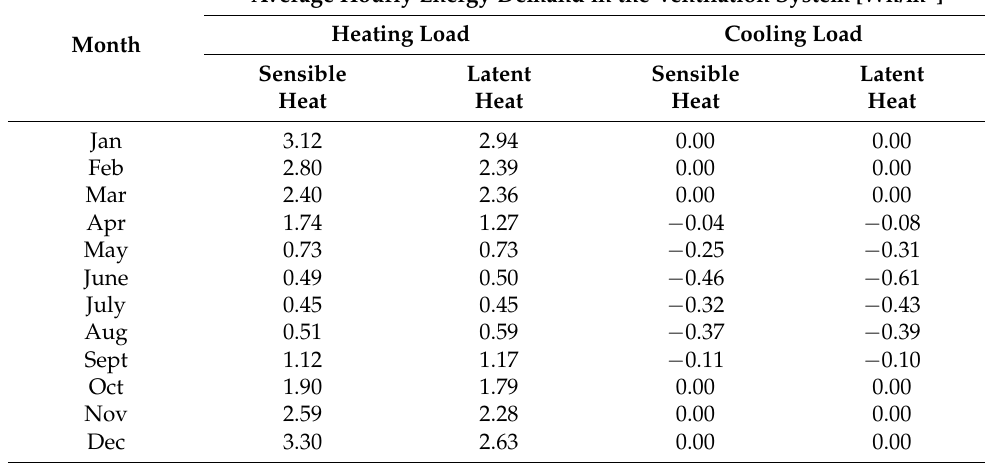
Table 2. Sensible and latent heat recovery in the GAHE under heating and cooling conditions— average hourly energy load per 1 m 2 of usable floor area [Wh/m 2